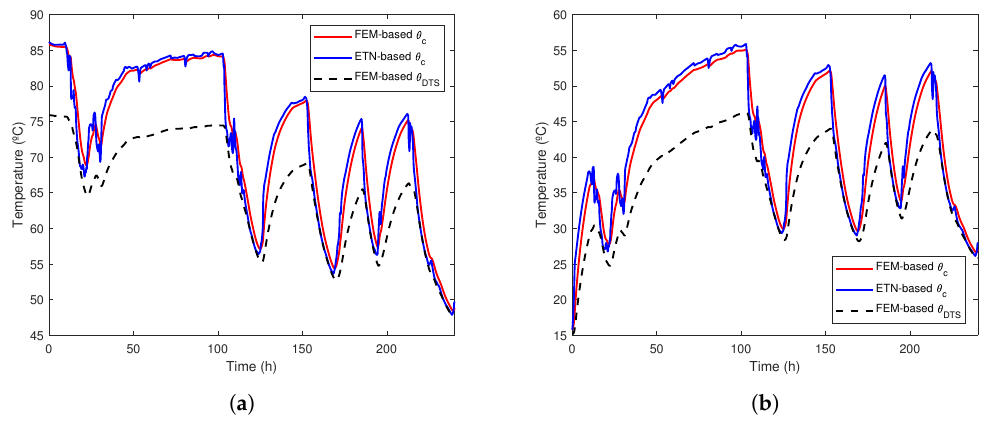
Figure 24. Estimation results for θ c in Cable 2E: ( a ) Case 1; ( b ) Case 2.